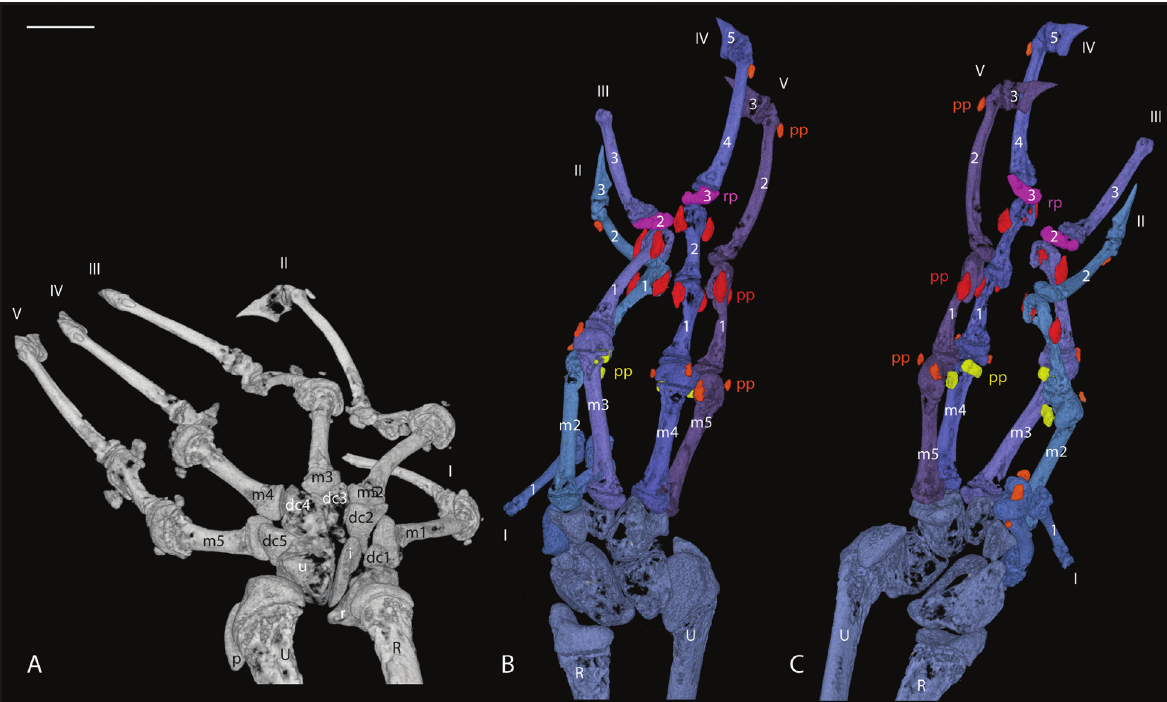
Figure 4. µ CT images of the manus of an adult Hemidactylus (ZMB 87075). Left (A) and right (B, C) manus in dorsal (A, B) and ventral (C) view. Large lateral paraphalanges are shown in red, small nubbin-like ones laterally and dorsally in orange, and ventral ones in yellow. Note the reduced antepenultimate in pink in (B, C) . Scale bar is 500 µ m. Abbreviations: dc – distal carpals; m – metacarpals; p –pisiform; pp – paraphalanges; R – radius; r – radiale; rp – reduced phalanges; U – ulna; u – ulnare; 1-5 – pha- langes 1-5; I-V – digits I-V.